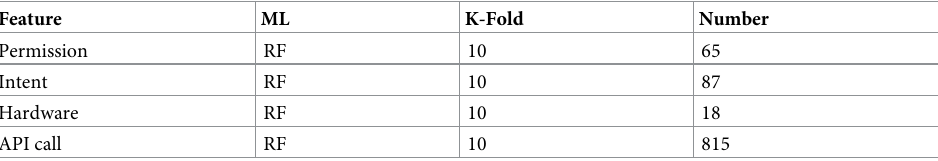
Table 11. The details of the features processed by